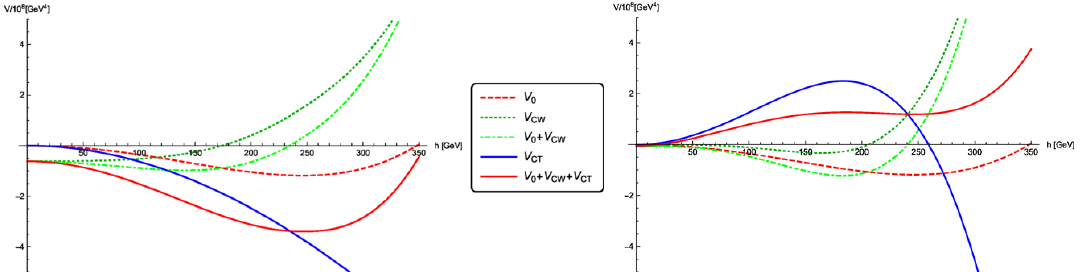
Figure 2 . Tree level and loop-correction contributions to the potential at zero temperature for two model points with tan (cid:12) = 1 ; sin( (cid:12) (cid:0) (cid:11) ) = 1. The remaining parameters corresponding to the point shown in the left (right) plot are (cid:21) 1 = (cid:21) 2 = (cid:21) 3 = 2 : 9 (6 : 36) ; (cid:21) 4 = (cid:0) 8 : 5 ( (cid:0) 12) ; (cid:21) 5 = 3 : 3 ( (cid:0) 0 : 2) ; m 12 = 315 ( (cid:0) 70) GeV. Clearly, the point shown in the left plot has a true EW vacuum while the one on the right plot has only a local minimum at v